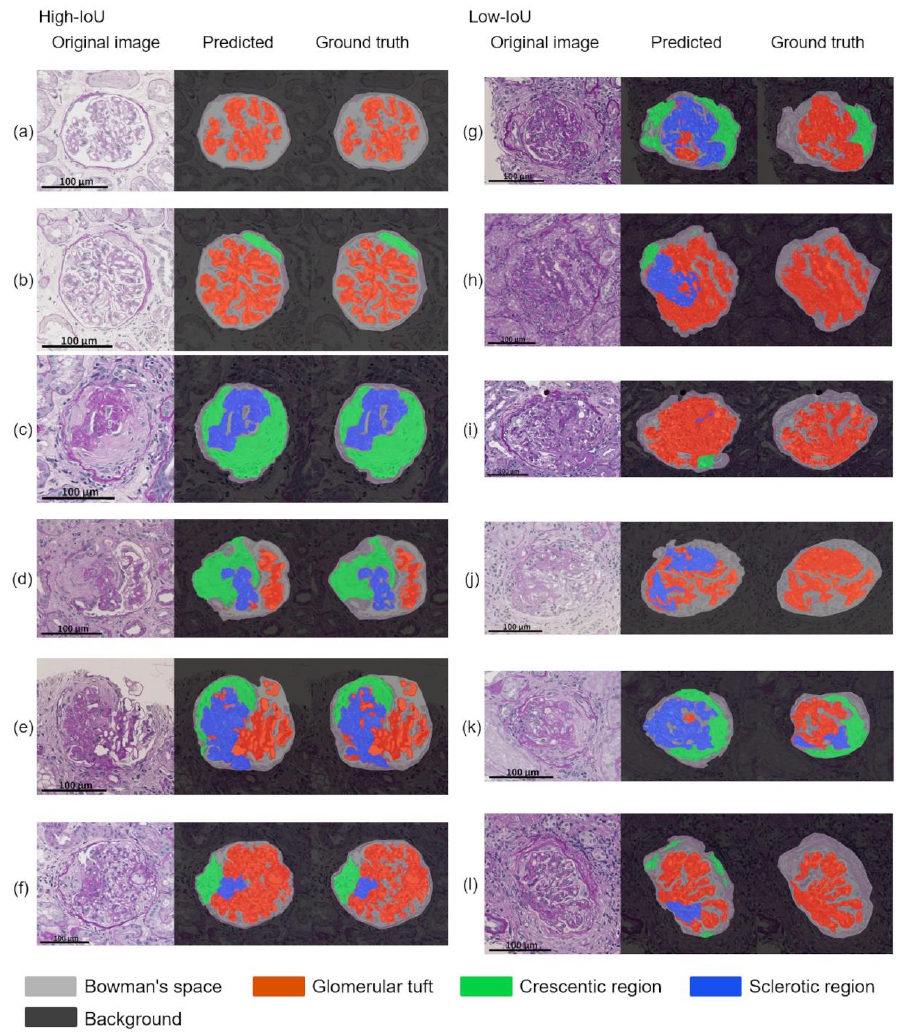
Figure 4. Example of the glomerular component segmentation obtained by the pipeline of K to T (predicted by the external model). The left column shows examples with higher mean intersection over union (IoU) of ( a ) 0.894, ( b ) 0.879, ( c ) 0.846, ( d ) 0.818, ( e ) 0.792, and ( f ) 0.780. The right column shows examples with lower mean IoU of ( g ) 0.377, ( h ) 0.384, ( i ) 0.412, ( j ) 0.417, ( k ) 0.438, and ( l ) 0.453. In the right column ( a – f ), the Bowman’s space, glomerular tuft, crescentic, and sclerotic region are correctly segmented. The pairs of the proportions of the sclerotic region of ground truth that are predicted in left column are ( a – c ) 0.0 to 0.0, ( d ) 0.485 to 0.446, ( e ) 0.451 to 0.518, and ( f ) 0.085 to 0.101, which are generally corresponding. ( g ) Most of the glomerular tuft region is incorrectly segmented as the sclerotic region, and the left side of the Bowman’s spaces are incorrectly segmented to the crescentic regions. ( h ) The left side of the glomerular tuft region is incorrectly segmented to the sclerotic region, and the upper left Bowman’s space is incorrectly segmented as the crescentic region. ( i ) The Bowman’s spaces in the glomerular tuft gaps are incorrectly segmented as the glomerular tuft areas, and the bottom of the glomerular tuft is incorrectly segmented as the crescentic regions. ( j ) The upper and lower left glomerular tuft areas are incorrectly segmented as the sclerotic regions. ( k ) Most of the glomerular tuft region from the upper left to the center is incorrectly segmented to the sclerotic region. ( l ) The lower left glomerular tuft region near the vascular pole is incorrectly segmented to the sclerotic region, and several small regions around the Bowman’s space are incorrectly segmented to the crescentic regions. The pairs of the proportions of the sclerotic region of ground truth that are predicted in right column are ( g ) 0.0 to 0.832, ( h ) 0.0 to 0.282, ( i ) 0.0 to 0.009, ( j ) 0.0 to 0.430, ( k ) 0.247 to 0.967, and ( l ) 0.0 to 0.158. All scale bars indicate 100